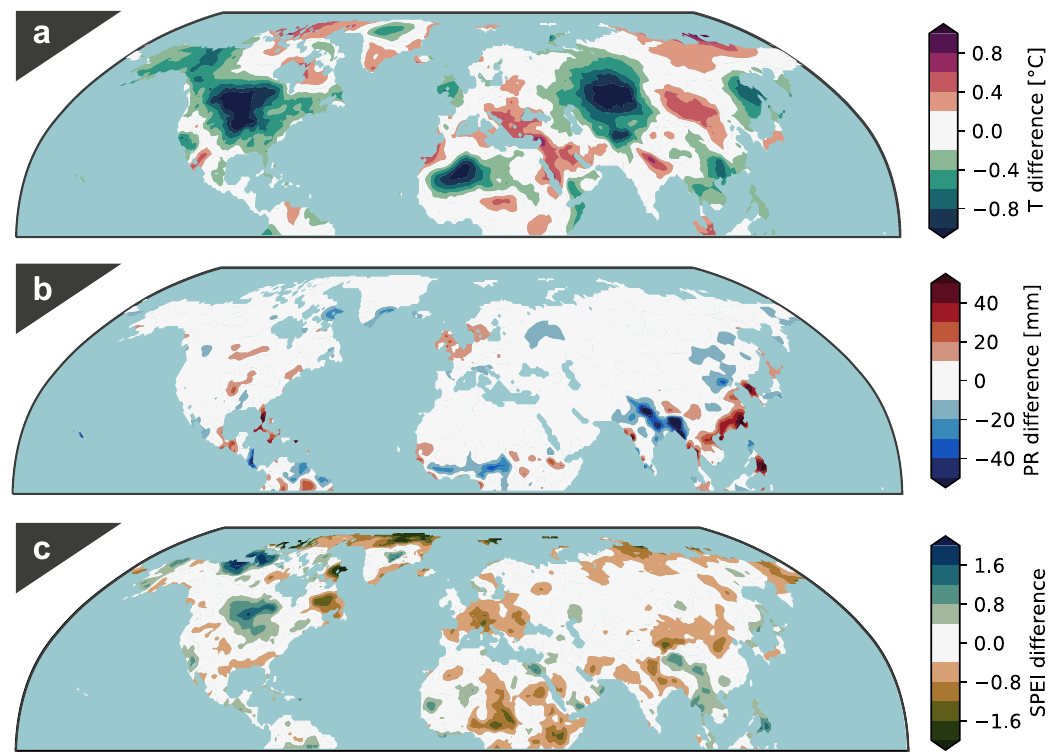
Fig. 2 Differences in trends in climate model simulations and observations. a – c The differences are shown for the periods 1975 – 1989 and 2000 to 2014 (JJA only) in CMIP6 historical simulations relative to observations. A value of 0 represents that the trend in observations is the same as that of the model ensemble. Negative values indicate that trend in observations is stronger than in the model ensemble, whereas positive values show the opposite case. a Surface air temperature, b precipitation and c